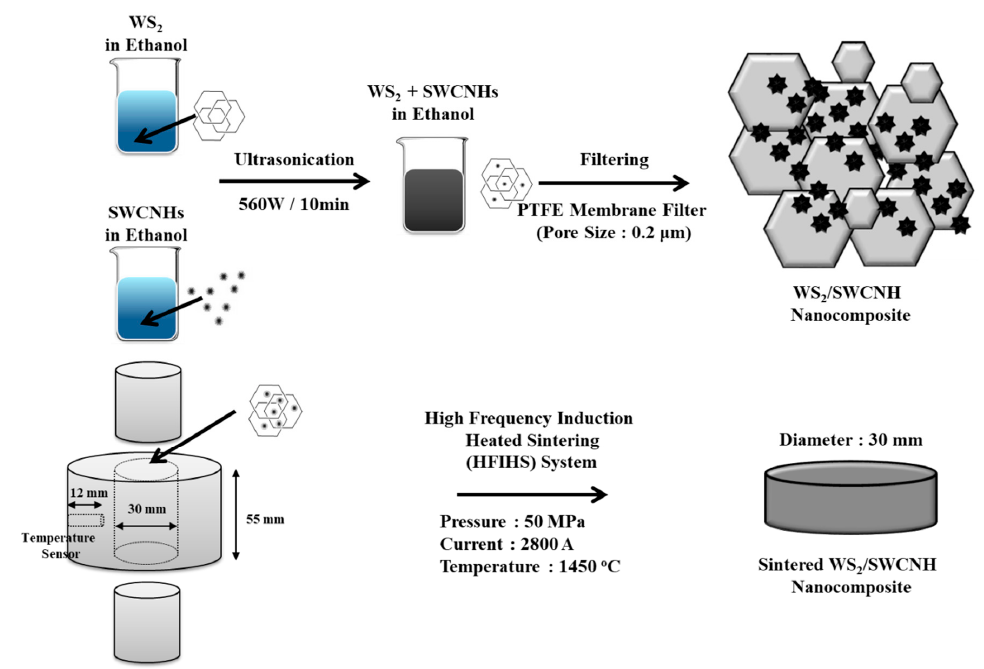
Figure 1. Schematic illustration of the preparation process of the tungsten disulfide (WS 2 )/single- walled carbon nanohorn (SWCNH) nanocomposites. carbon nanohorn (SWCNH)